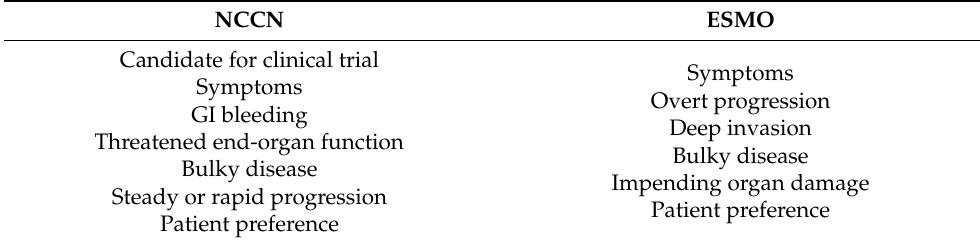
Table 4. Treatment indications for residual gastric